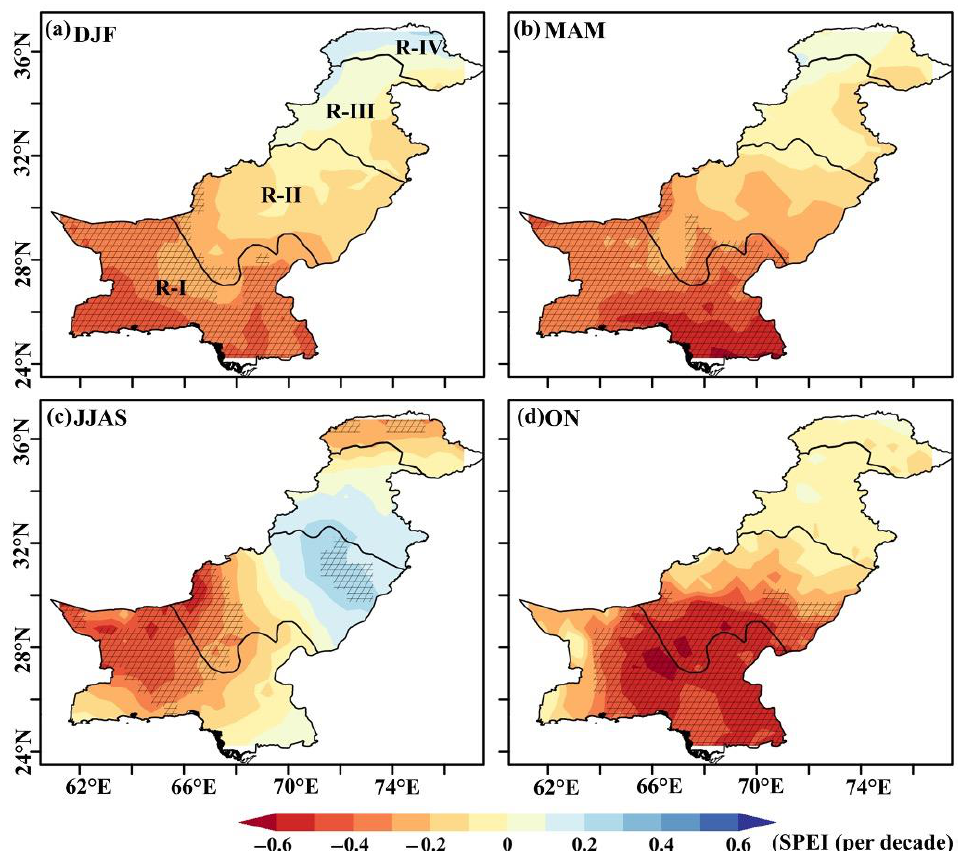
Figure 6. Spatial distribution of Mann–Kendal trend (per decade) of Standardized Precipitation Evapotranspiration Index (SPEI) during the ( a ) DJF (December to February; SPEI-3 at February), ( b ) MAM (March to May; SPEI-3 at May), ( c ) JJAS (June to September SPEI-4 at September), and ( d ) ON (October to November; SPEI-2 at November) Season over Pakistan for 1980 – 2018. The hatched area shows a statistically significant trend at a 90% confidence level. R-I, R-II, R-III, and R-IV represent the hyper-arid, arid, humid, and glacial regions, respectively.